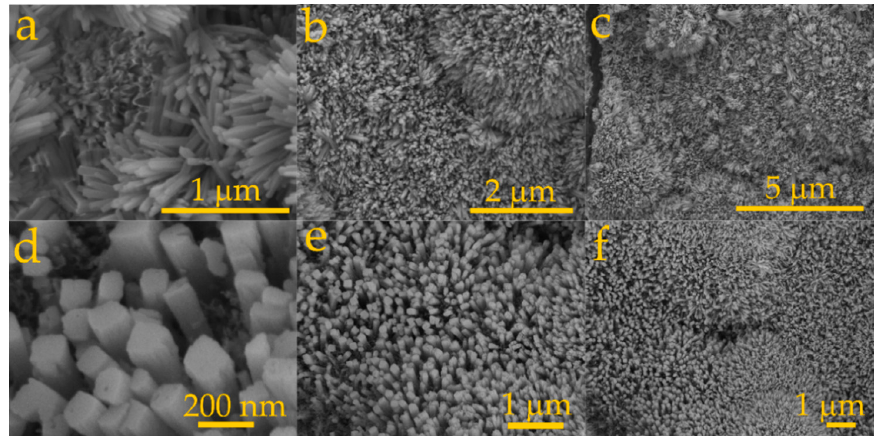
Figure 2. FE-SEM images of nanostructured oxides formed by copper anodizing in 0.1 M Na 2 CO 3 ( a – c ) (31 V, 1 h, 20 °C) [60] and 0.1 M K 2 CO 3 ( d – f ) (35 V, 1 h, 10 °C [61]). ( a – c ) has been reproduced from